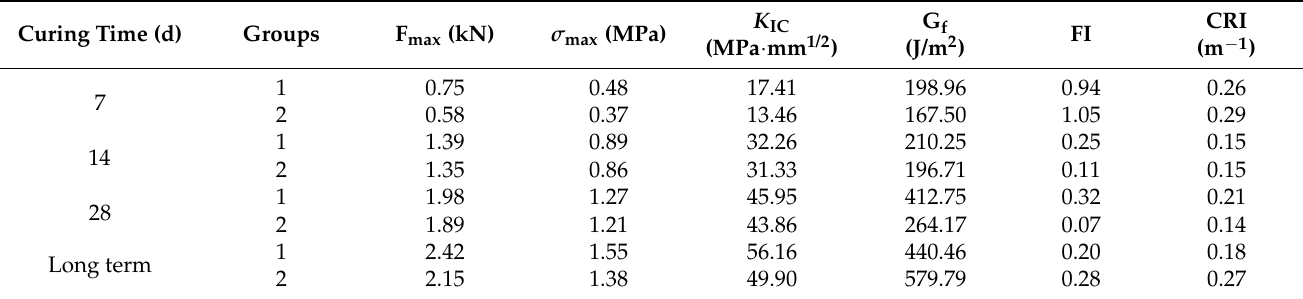
Table 4. The calculation of fracture parameters.